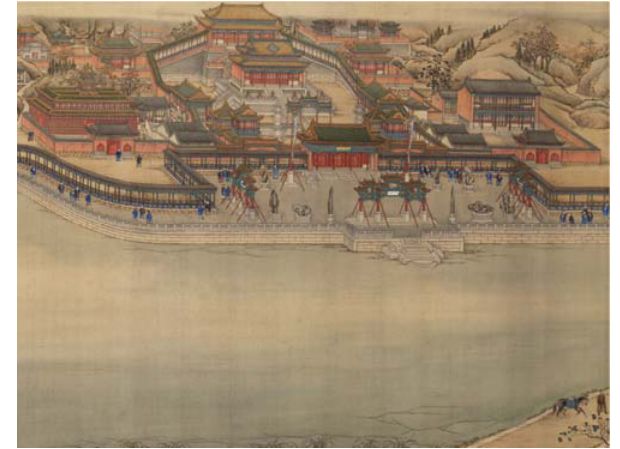
Fig.2. Da Bao En Yan Shou Temple 大报恩延寿寺